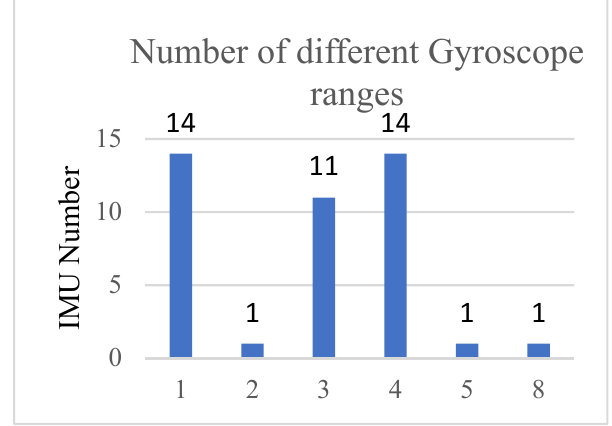
Figure 4. The different ranges of Gyroscopes.